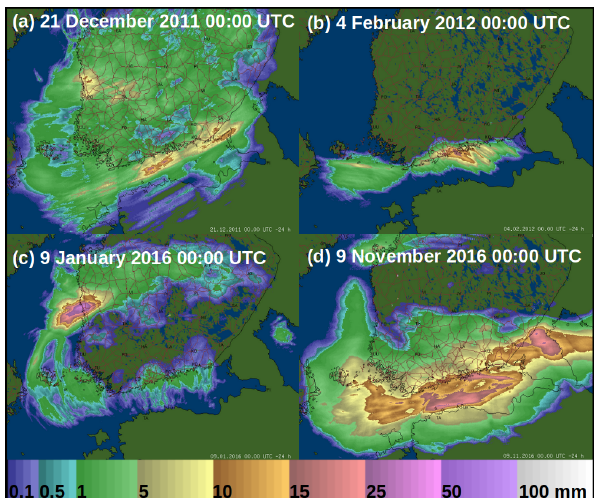
Figure 1. Radar images of accumulated precipitation (mm per 24h − 1 ) during the past 24h within the four selected cases (A–D, see Table A1 for details). Images from radar service of FMI intranet.